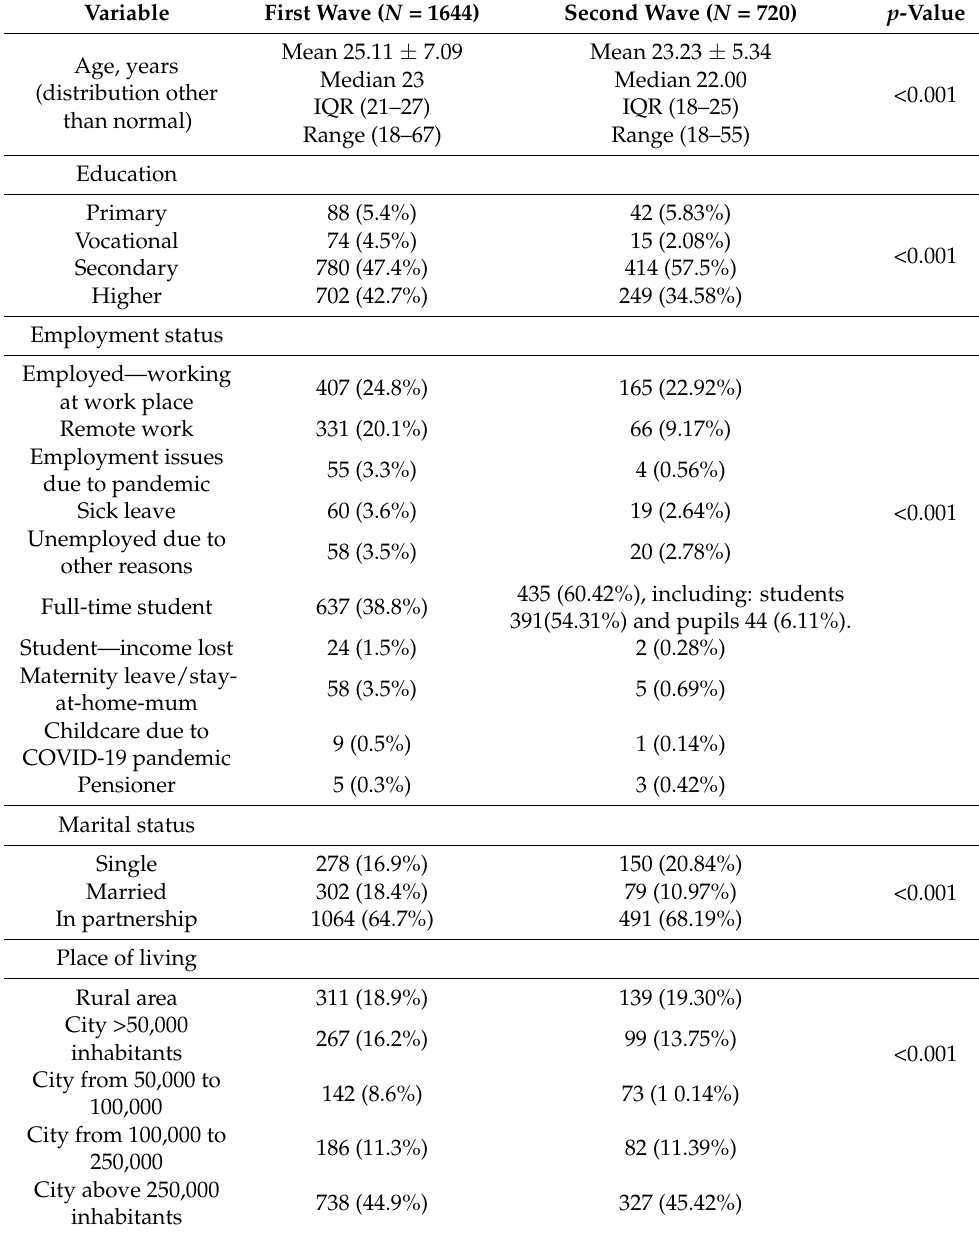
Table A1. Study group characteristics during the first and second wave of the COVID-19 pandemic.